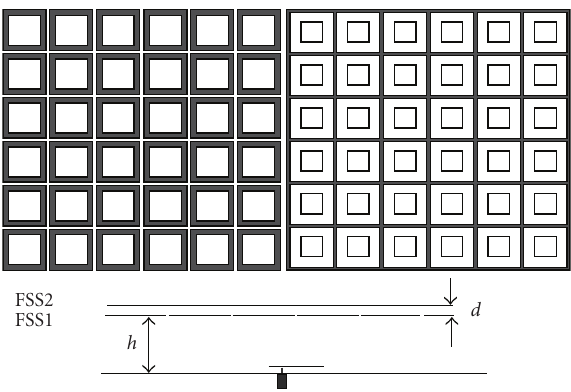
Figure 6: Schematic design of the FSS layers and the resonator antenna formed between the double-layer FSS and the ground.